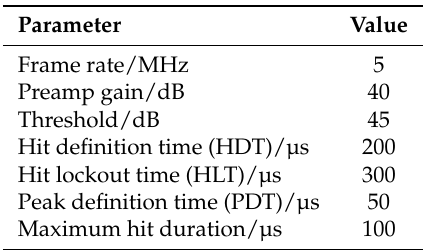
Table 1. Parameters of the AE acquisition system (Sensor: